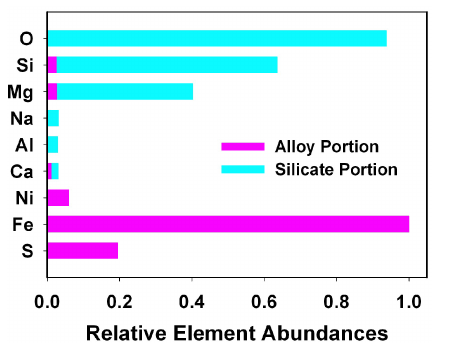
Figure 4. Relative abundances of the major and minor elements in the Abee enstatite chondrite, normalized to iron, showing their relative amounts in the alloy and silicate portions. Note that cal- cium (Ca), magnesium (Mg), and silicon (Si), normally lithophile elements, occur in part in the alloy